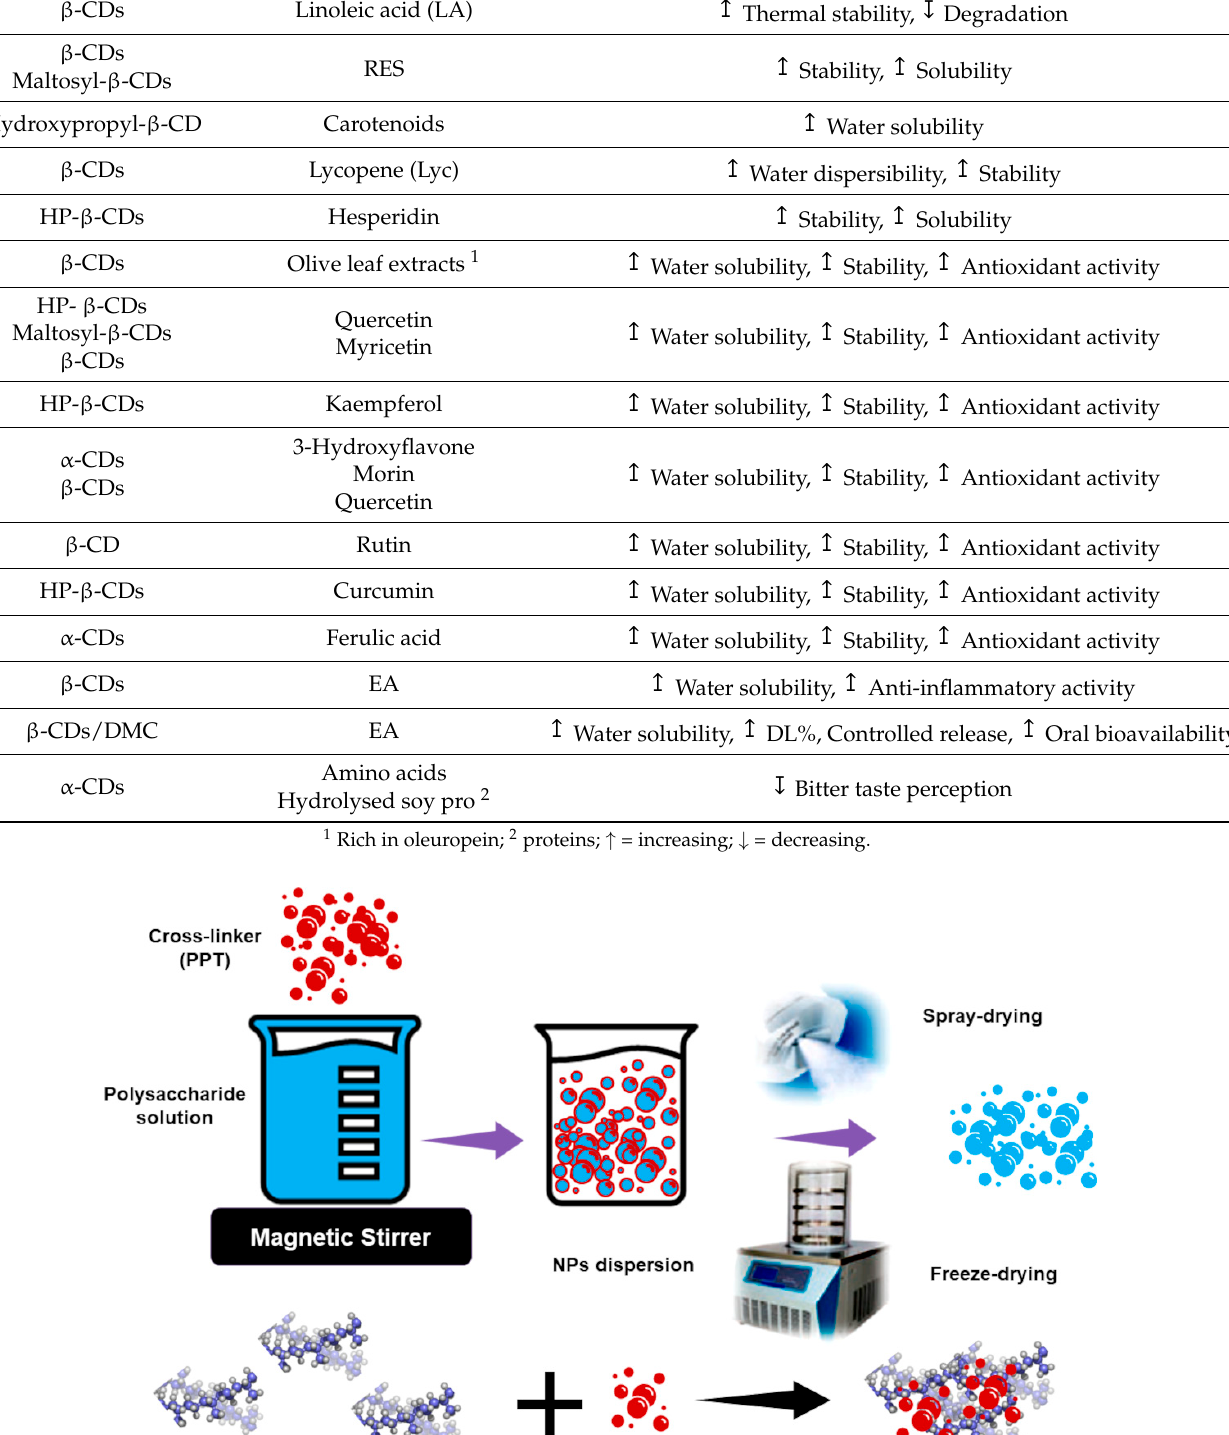
Figure 8. Process to prepare PNPs.